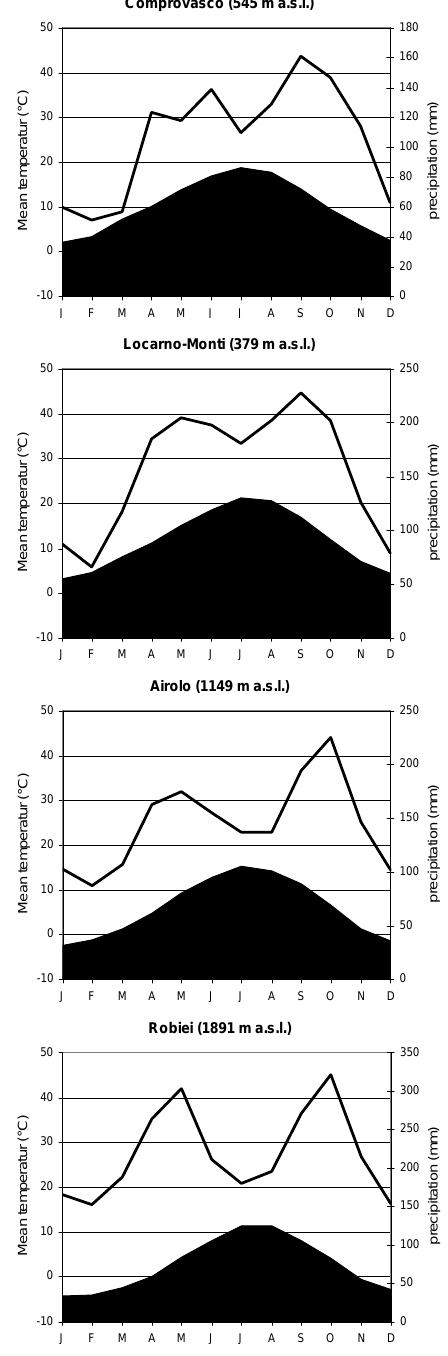
Fig. 2. Climatic diagrams referring to the period from 1970 to 2000 for representative meteorological stations of the study area (source: Spinedi and Isotta, 2004).